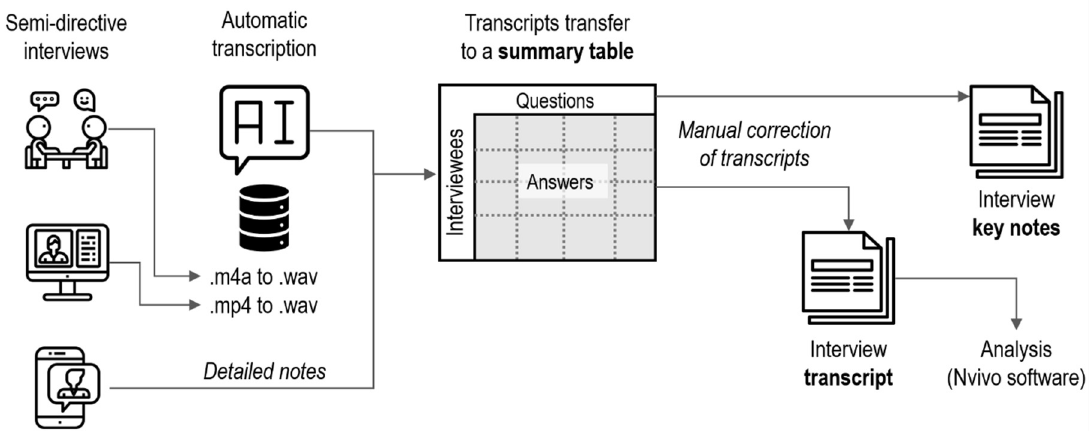
Figure 1. The four steps of the data treatment and analysis, from interviews to raw data preparation and final transcription with manual corrections and synthesis.